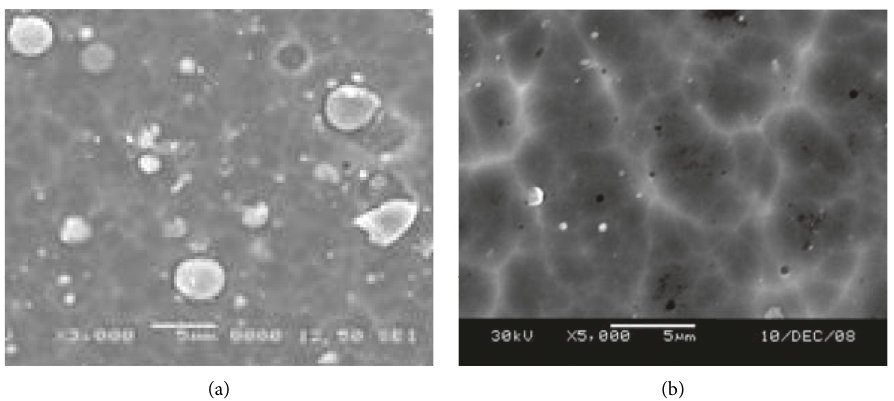
Figure 2: SEM micrographs of coated surfaces: (a) standard arc PVD; (b) FCVAD technology [37].